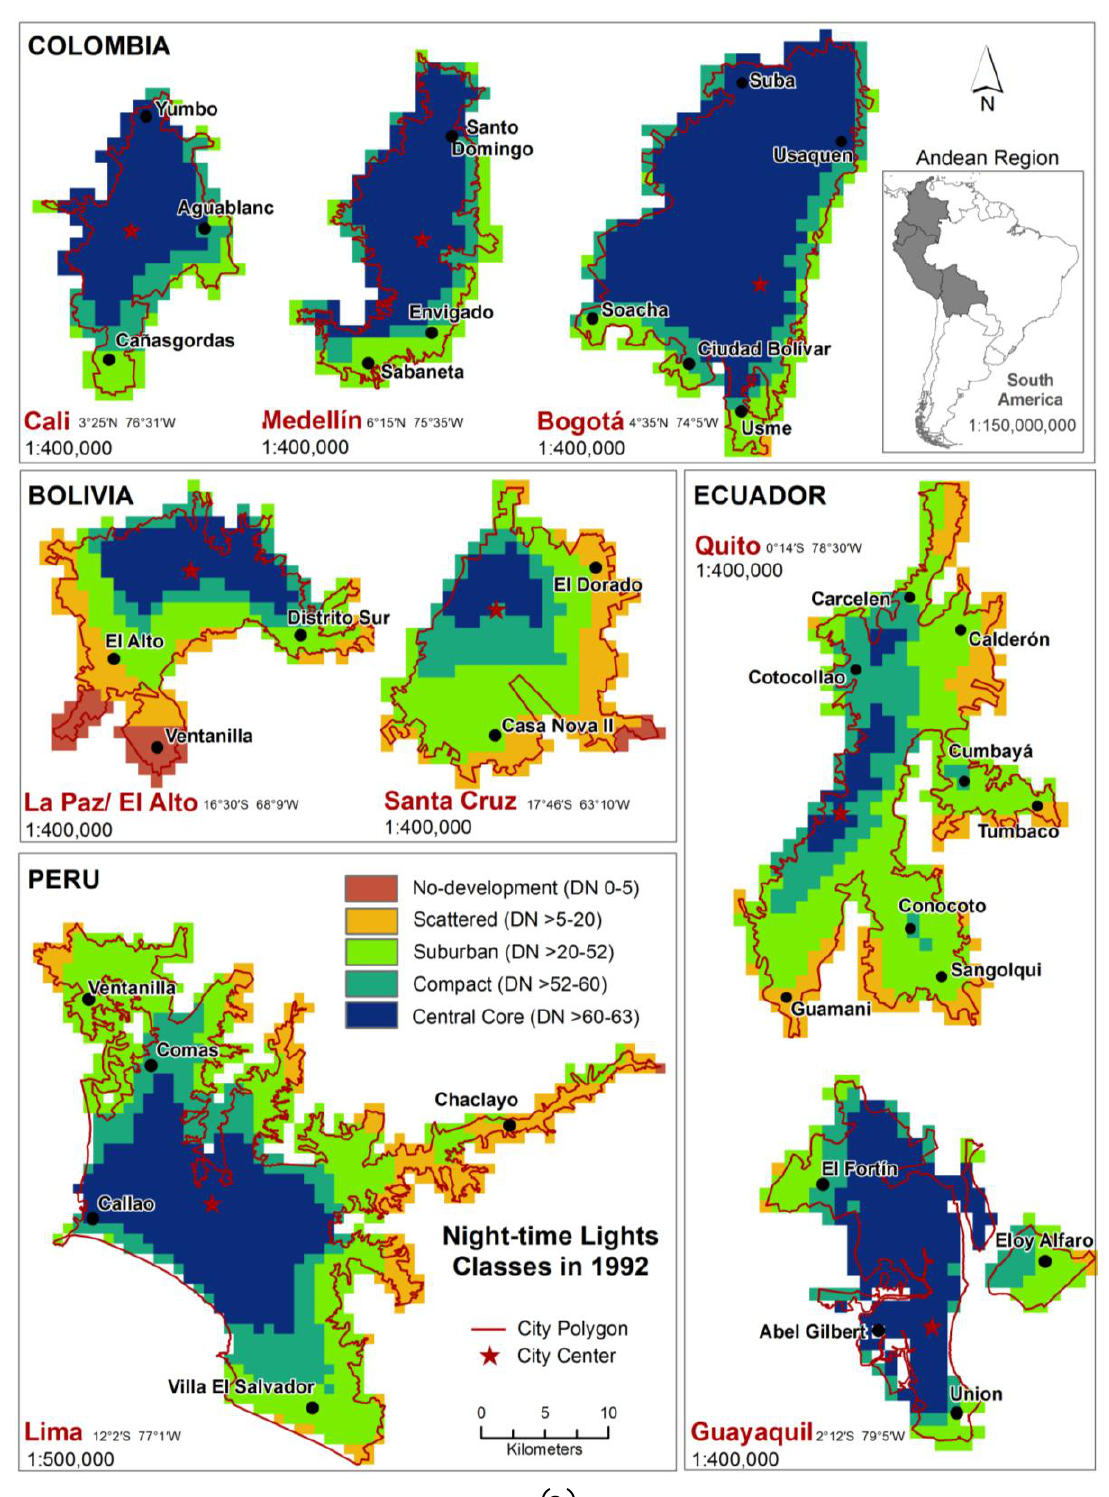
Figure 5. ( a ) Map of the distribution of the night-time lights (NTL) classes in 1992 within the city polygons. ( b ) Map of the distribution of the night-time lights (NTL) classes in 2009 within the city